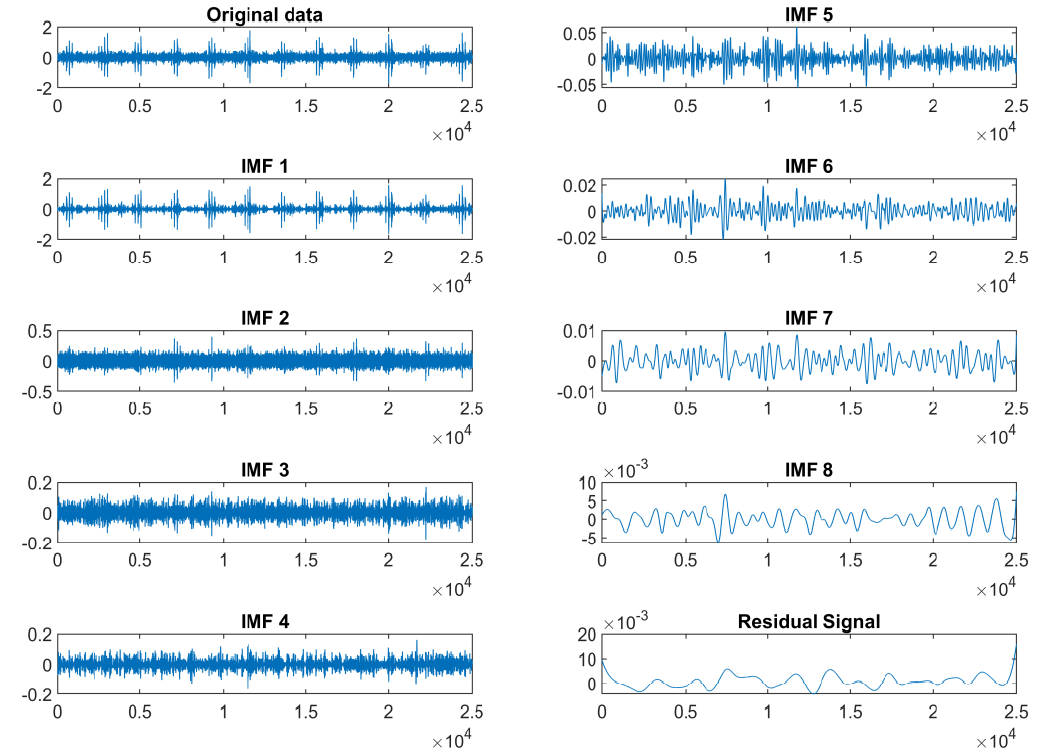
Figure 4. The original signal, IMFs, and residual signal as a result of EEMD decomposition for a roller fault (x and y-axis represent the number of samples and amplitude, respectively).